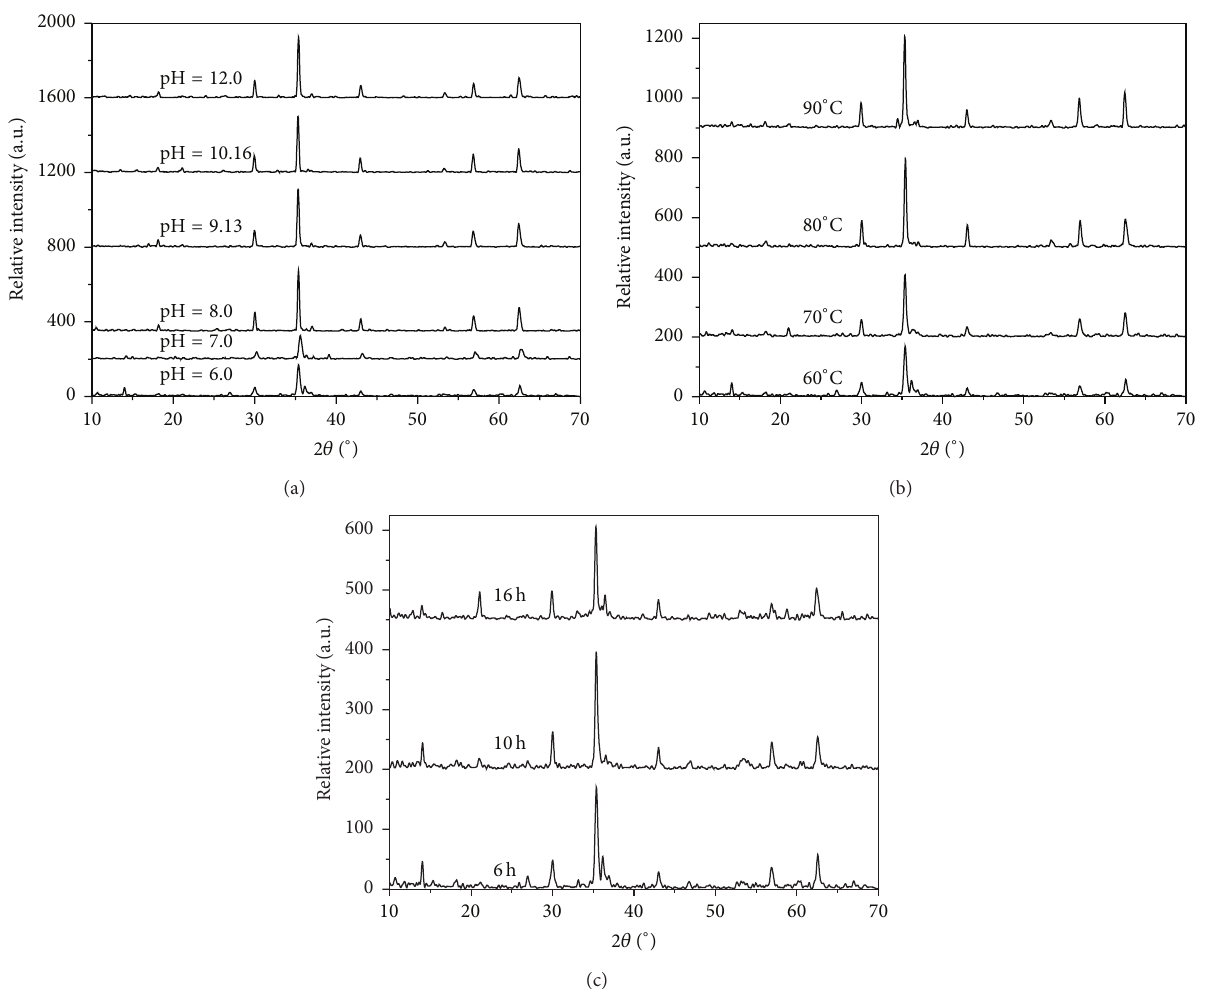
Figure 4: XRD patterns of 𝛾 -Fe 2 O 3 powders prepared under the following conditions: (a) various pH values at 60 ∘ C for 6h; (b) various reaction temperatures at pH of 6.0 for 6h; (c) various reaction times at 60 ∘ C and pH of